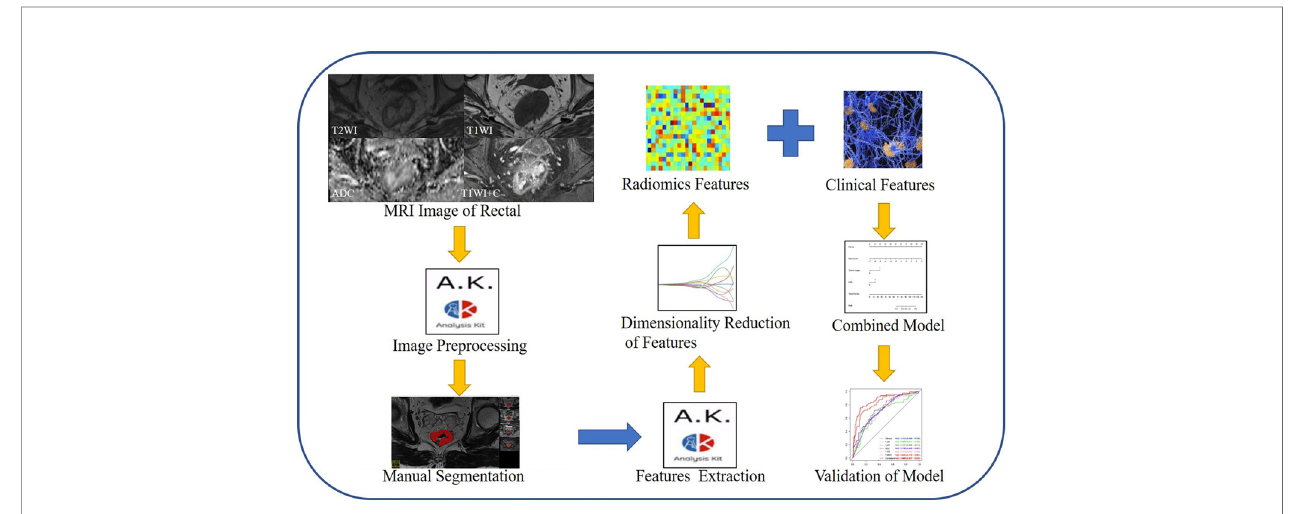
FIGURE 2 | The radiomics work fl